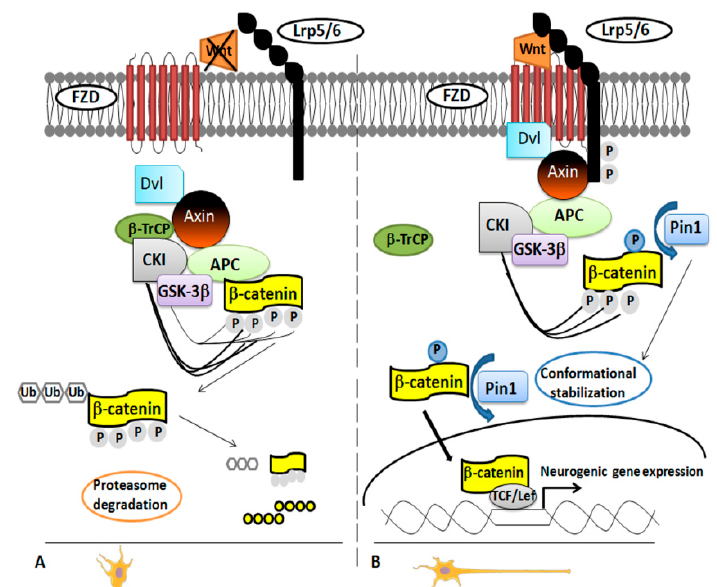
Figure 1. Pin1 modulation of Wnt/ β -catenin pathway. Panel A. Inactivation of the Wnt/ β -catenin pathway. In the absence of Wnt stimulation, levels of β -catenin decrease in the cytoplasm owing to ubiquitination and degradation by the proteasome. Both casein kinase 1 α (CK1 α ) and glycogen synthase kinase-3 β (GSK-3 β ) phosphorylate β -catenin to assemble a complex of proteins (named “destruction complex”). The complex includes scaffold protein axin, adenomatous polyposis coli (APC) and β -transducin repeat-containing E3 ubiquitin protein ligase ( β -TrCP). Once phosphorylated, β -catenin is recognized by β -TrCP, ubiquitinated and then degraded. Panel B. Activation of the Wnt/ β -catenin pathway. A Wnt ligand binds a Frizzled (Fz) receptor and coreceptors LRP5/6 activating the protein Dishevelled (Dvl) mostly by phosphorylation. This modification triggers the recruitment of axin to the phosphorylated tail of LRP and leads to the inhibition of the degradation pathway. Pin1 binds the β -catenin phosphorylated on the Ser246-Pro motif thus downregulating its binding with APC. By doing so, Pin1 catalyzes conformational stabilization of cytoplasmic β -catenin, which gets into the nucleus to regulate the transcription of Wnt target genes.